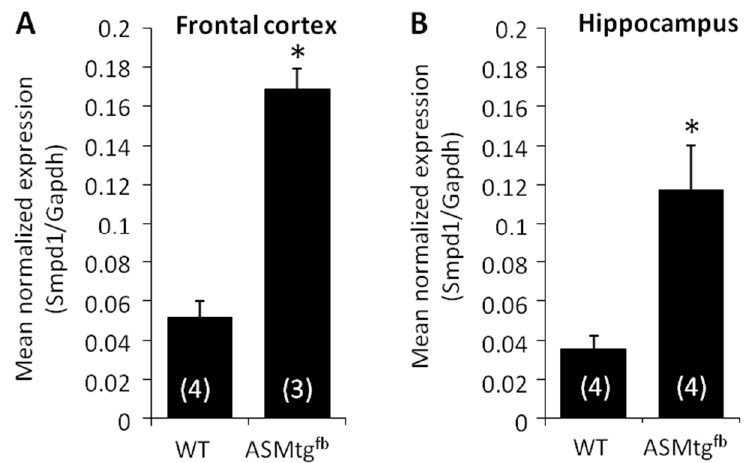
Figure 1. Asm-tg fb mice show an increase in the mRNA expression of Smpd1 , which encodes Asm. In both cortical and hippocampal tissues, male Asm-tg fb mice showed a significant increase in Smpd1 mRNA expression in comparison with WT mice. Data represent the means + SD, and numbers in parentheses indicate group sizes; * p <